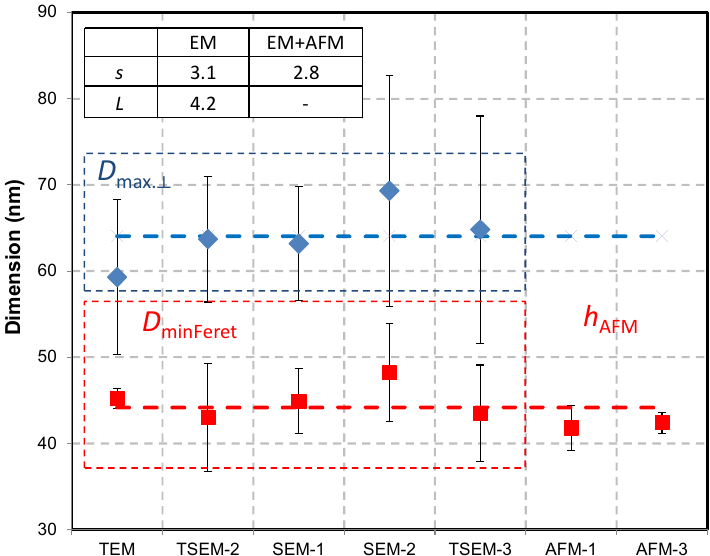
Figure 6. Size measurements of the nPSize03 material (nanoscale bipyramids) performed with different techniques and several laboratories. With EM, the measurands D MinFeret and D max. ⊥ allow the parameters s and L to be measured, such that the side of the square base and the length of the major axis are assessed, respectively. The inset table gives the data spread calculated with the standard deviation by taking into account the measurements with EM (electron microscopy) and EM + AFM. The uncertainty bars (k = 2) are also given with each laboratory mean value (lognormal distribution).